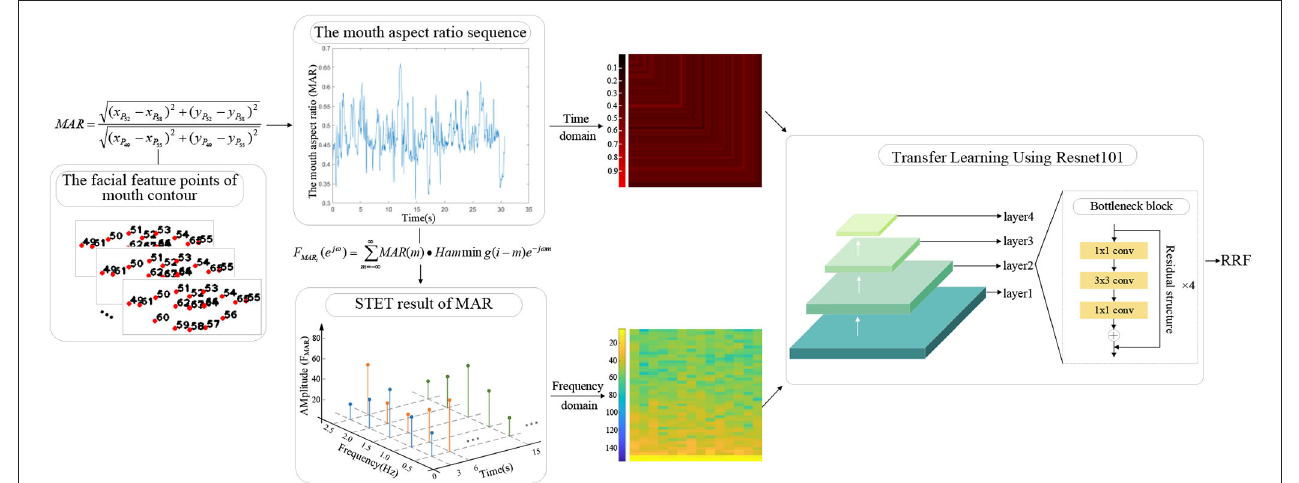
FIGURE 5 | Extraction of the reading-fluency-related